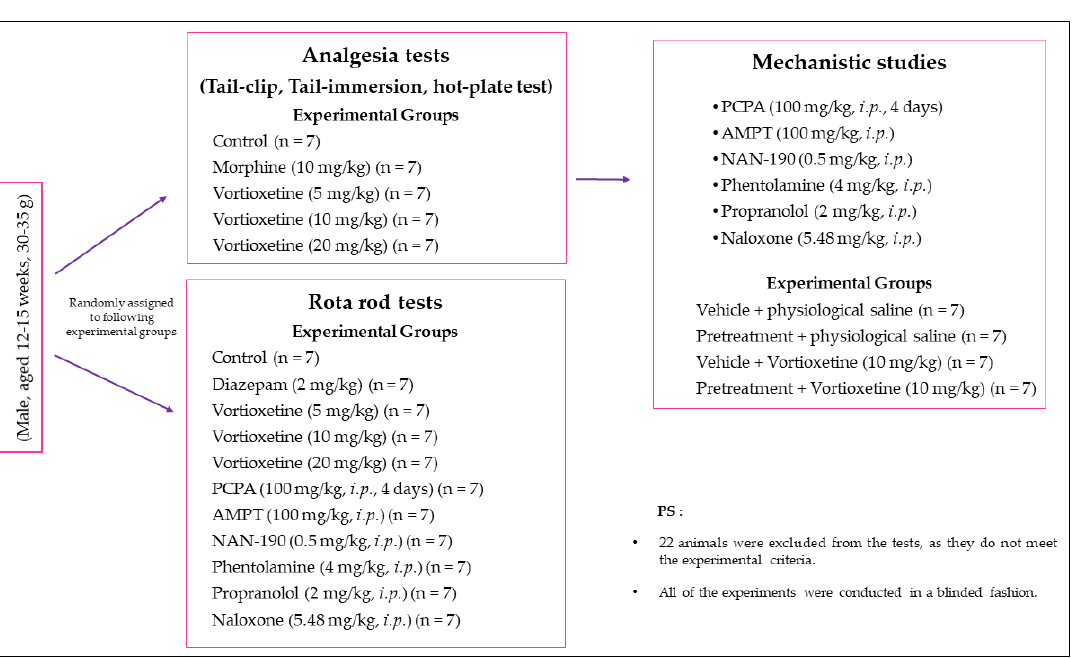
Figure 11. Brief summary of the experimental design.